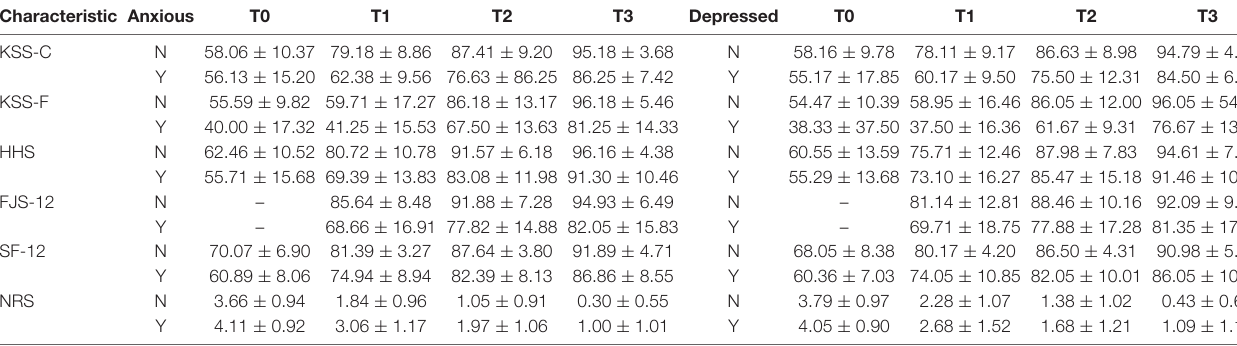
TABLE 3 | The evaluation index results before and after surgery had categorized by the preoperative HADS score. Characteristic Anxious